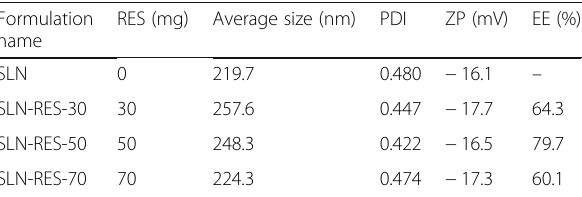
Table 1 The effect of the different ratio of drug to lipid on the SLN